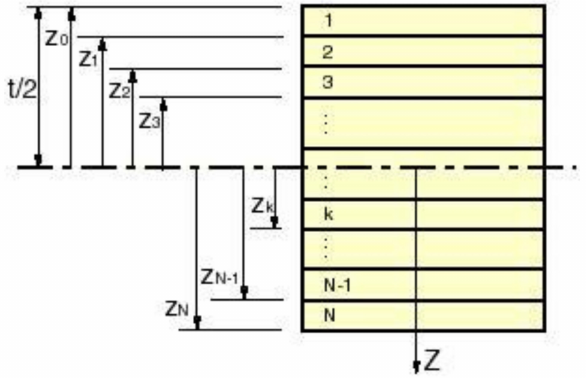
Figure 8. Layer configuration in a